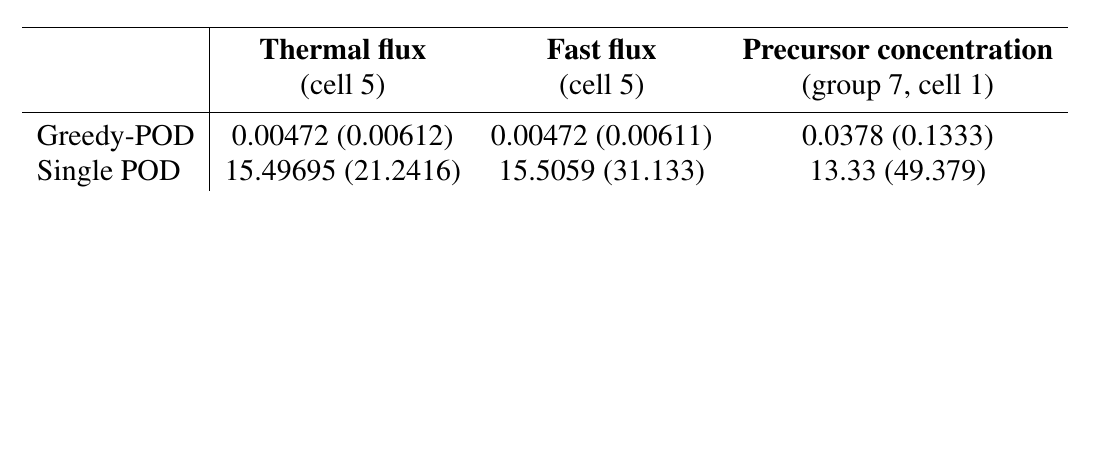
Table 4: the maximum relative errors (%) in the mean (standard